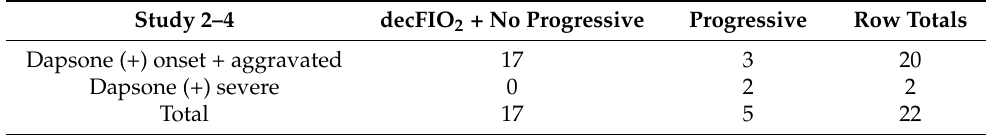
Table 5. Fisher’s exact test calculator.